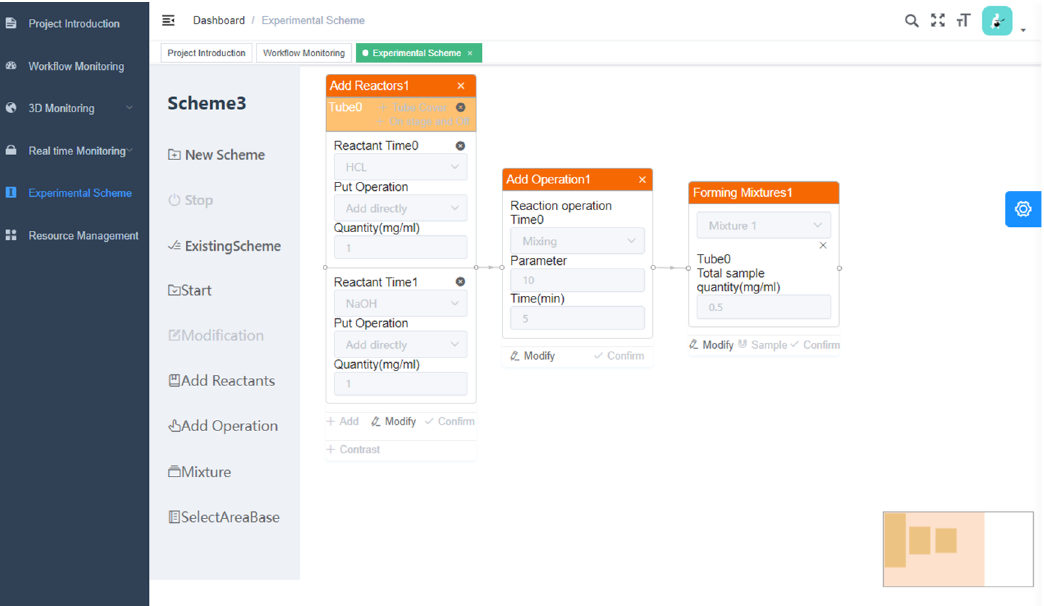
Figure 8. Illustration of the web page of the unmanned chemical system. The leftmost menu is the system administration section. The central section of the diagram shows the core content of the experimental design of an unmanned chemical system. First, we can drag ‘Add Reactants’, ‘Add Operation’, and ‘Mixture’ from the left menu to the empty configuration area on the right and fill in the required parameters. Then, we can click ‘Start’ to start the unmanned chemical system and the chemical experiment.